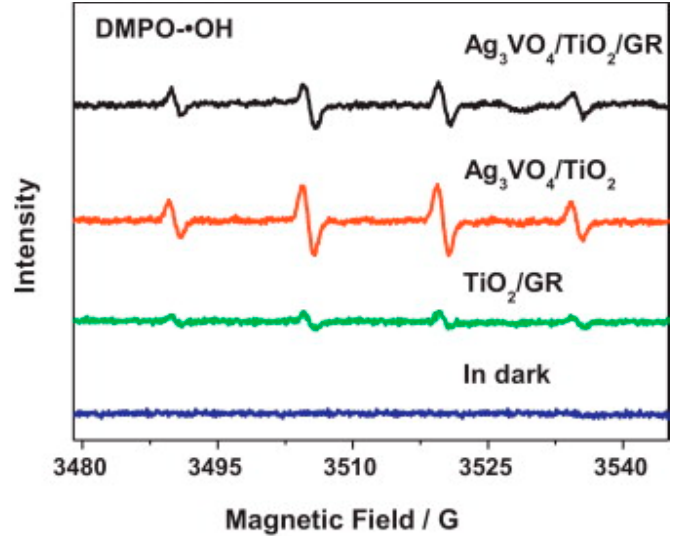
Figure 26. ESR spectra showing the formation of stable DMPO-based free radicals formed when doped TiO 2 -GR is irradiated with visible light. Reprinted with permission from reference [171]. Copyright 2013 Elsevier.